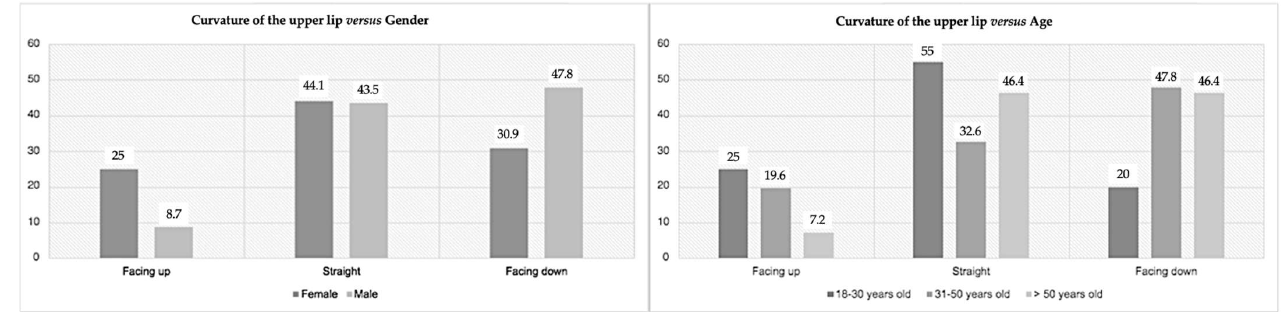
Figure 2. Prevalence of the upper lip curvature according to gender ( left ) and age ( right ).